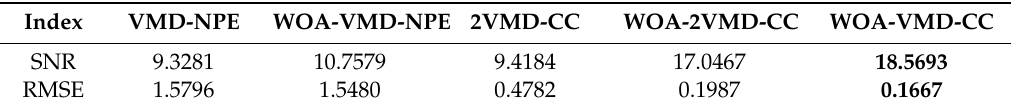
Figure 6. The denoising results of WOA-VMD-NPE and WOA-2VMD-CC. ( a ) WOA-VMD-NPE; ( b ) WOA-2VMD-CC. Table 2. Denoising evaluation indexes of VMD-NPE, WOA-VMD-NPE, 2VMD-CC, WOA-2VMD-CC and WOA ‐ VMD ‐ CC.